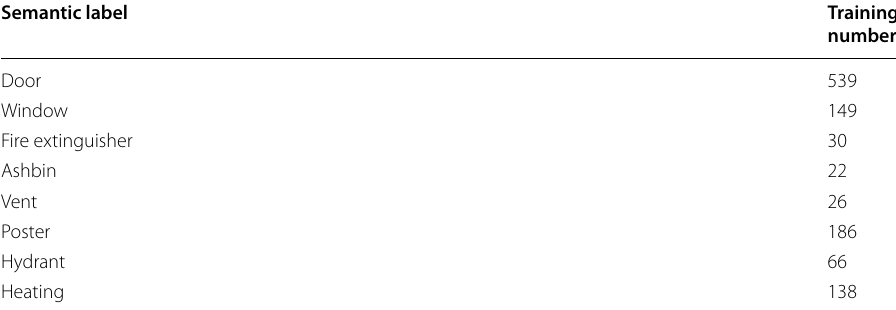
Table 1 The number of different semantic segmentations training in R-FCN Semantic label